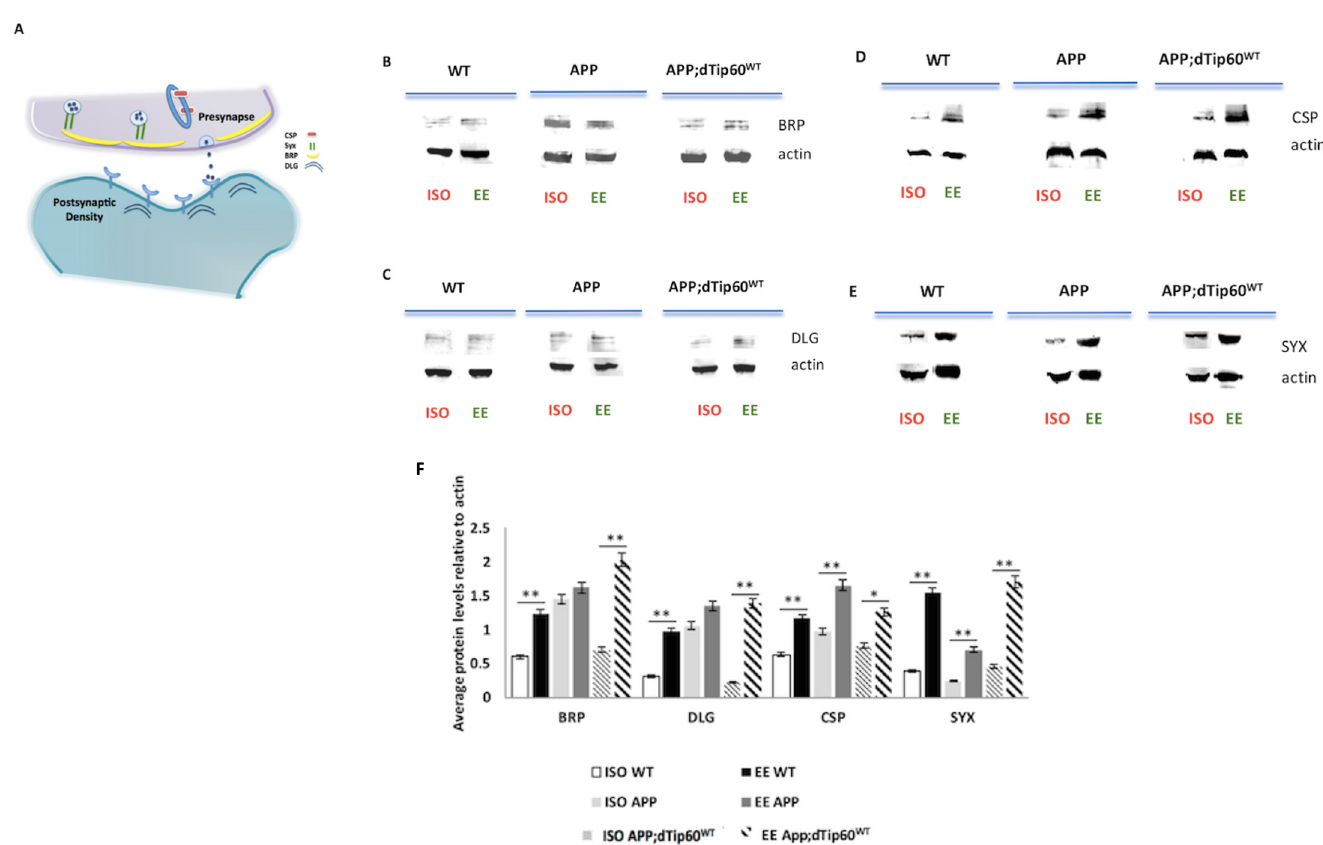
Fig 2. Tip60 restore EE induction of synaptic markers under APP neurodegenerative conditions. (A) The schematic of key synaptic maker components of Drosophila synapse. BRP, Bruchpilot; CSP, cysteine string protein; DLG, Discs-large; Syx, syntaxin. (B) Structural synaptic marker BRP and DLG protein production remained the same under different housing conditions under APP neurodegenerative conditions. (C) Structural marker protein production were induced under EE condition with enhanced Tip60 HAT activity. (D-E) Secretary marker protein Syx and CSP production were induced under EE conditions in both APP and APP;dTip60 WT fly brains. Data represent the mean of 3 replicates with error bars depicting 95% confidence interval. Student t-test was used to determine statistical significance between different housing conditions within the same genotype. ** P < 0.01, * P <